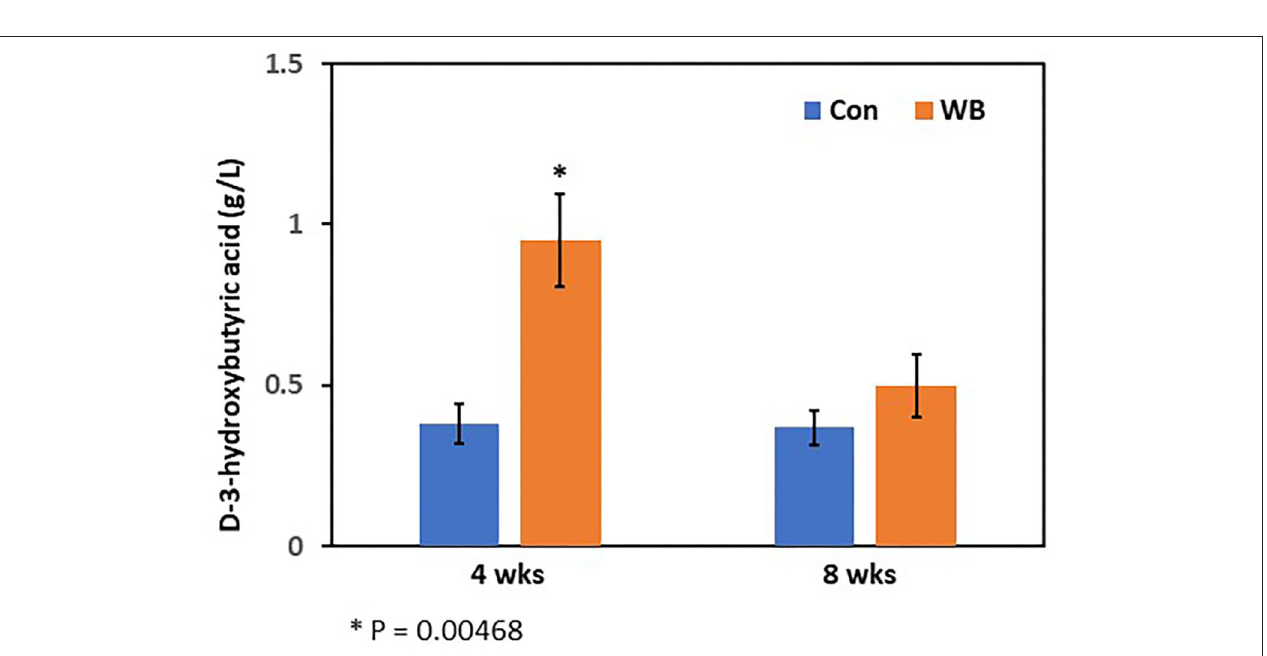
FIGURE 2 | Plasma 3-hydroxybutyric acid concentration in WB and controls. The 3-HB concentrations were determined at 4- and 8 wks of age. Bars indicate mean ± SE.